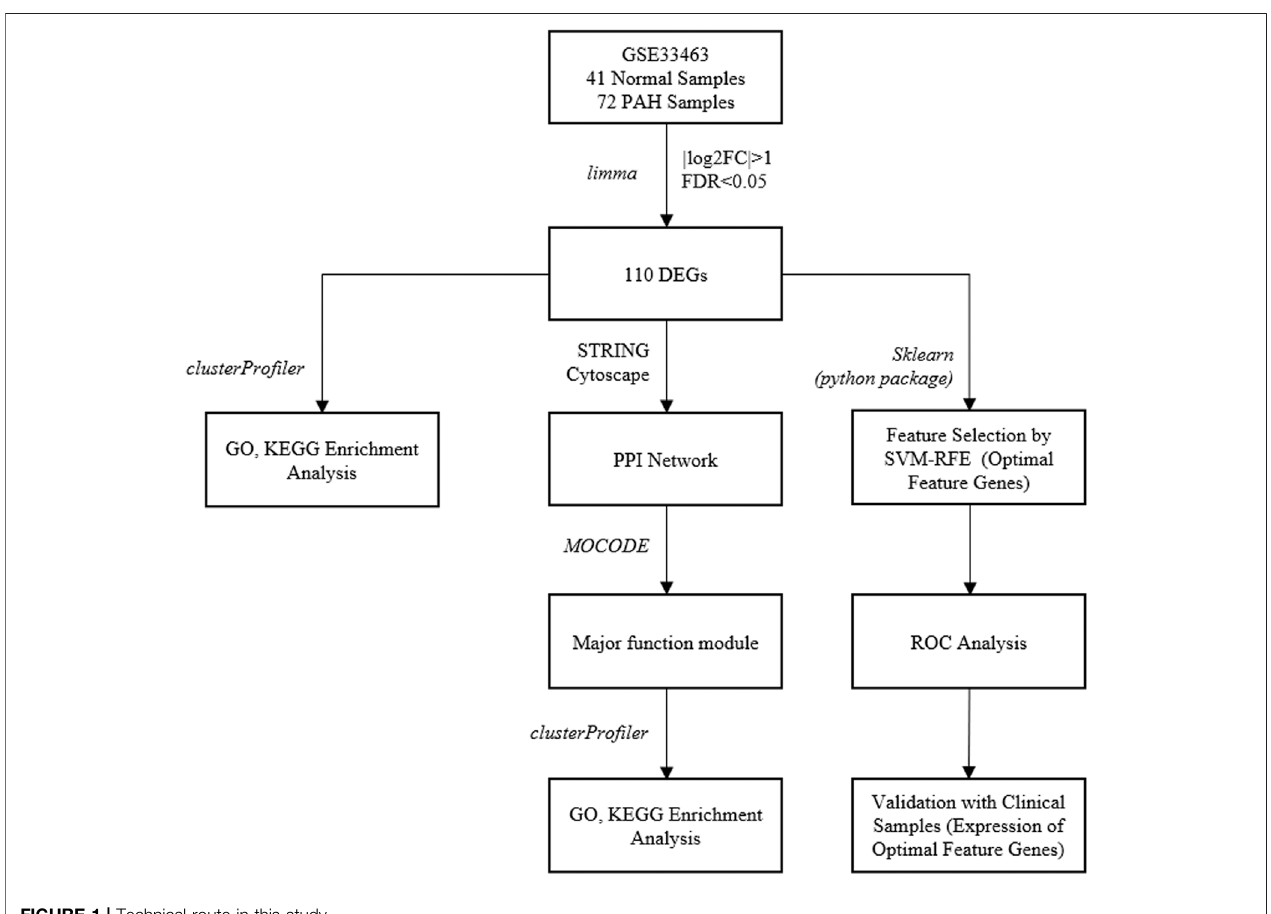
FIGURE 1 | Technical route in this study.